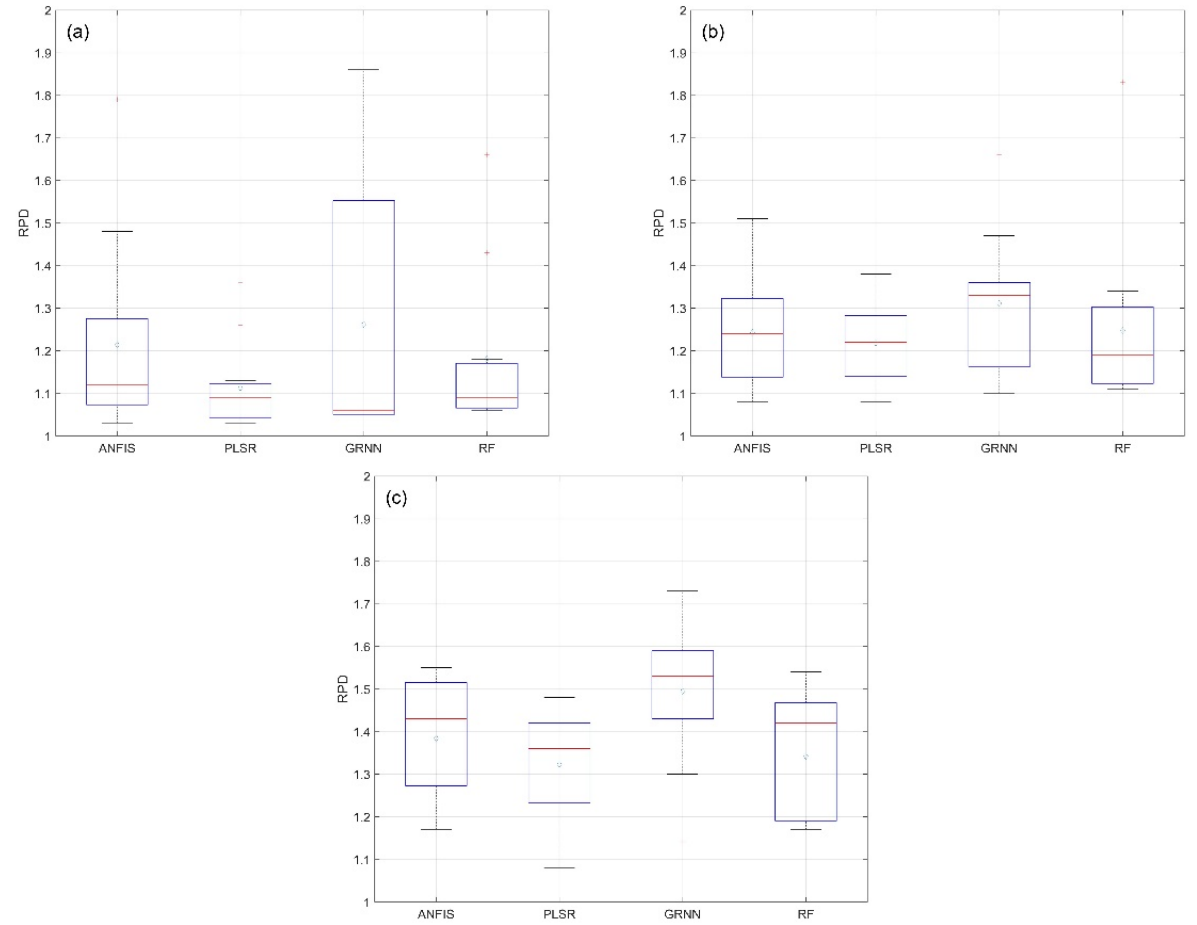
Figure 5. Boxplot of RPD versus heavy metal concentration estimation results using partial least squares regression (PLSR), random forest (RF), adaptive neural fuzzy inference system (ANFIS) and generalized regression neural network (GRNN) of ( a ) Hg, ( b ) Cr, ( c ) Cu.